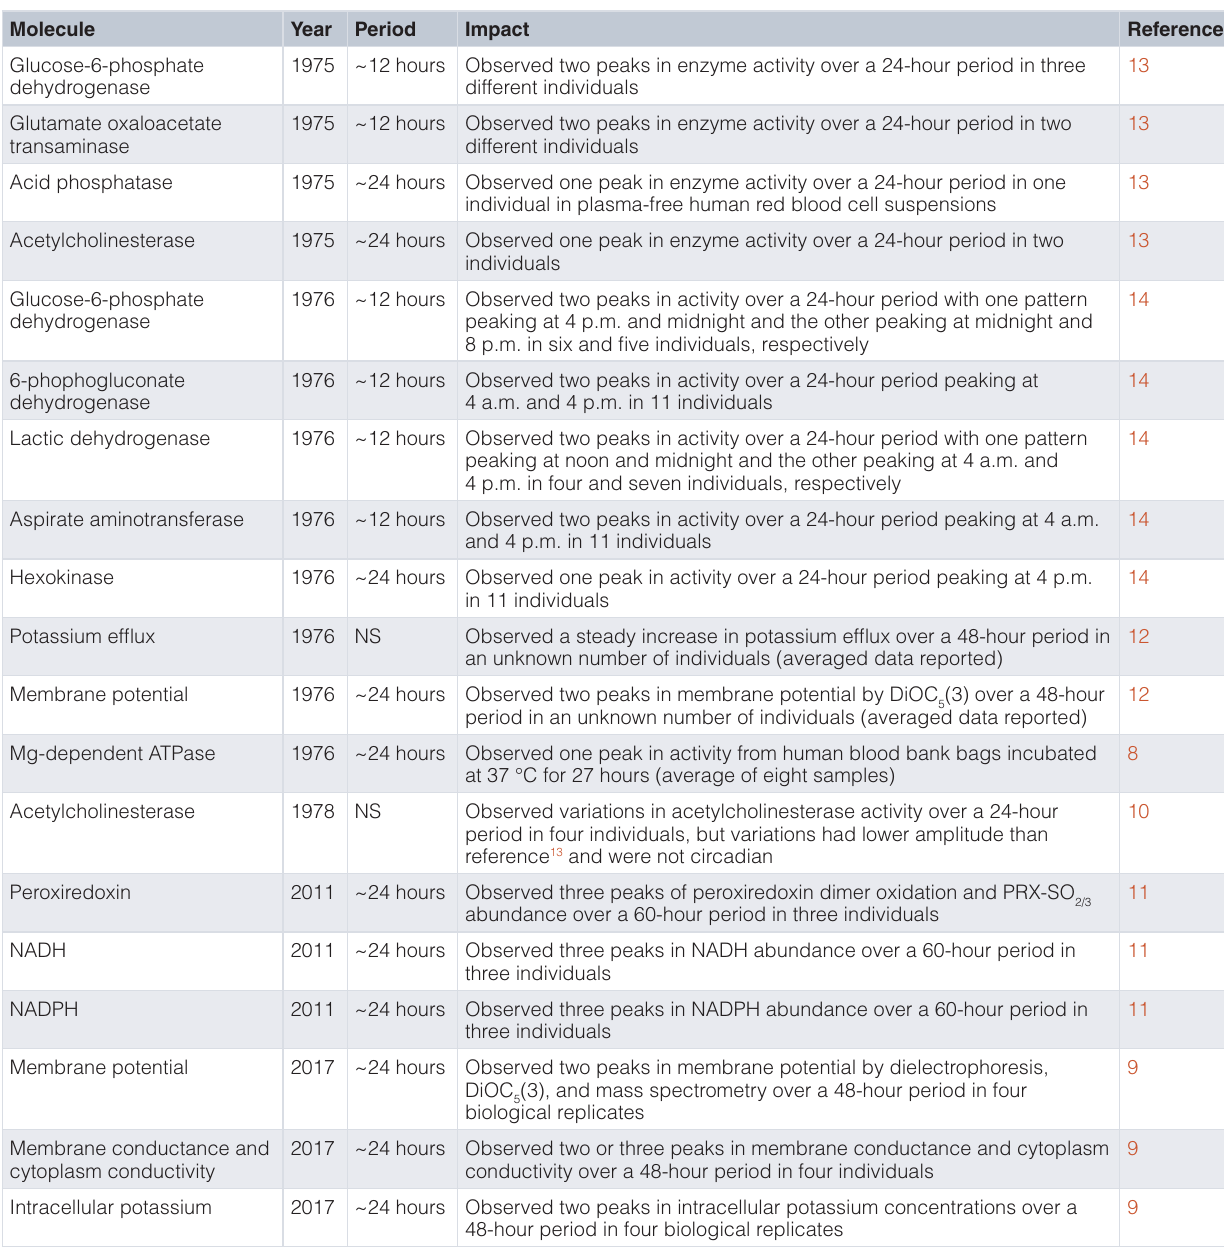
Table 1. Oscillatory phenomena observed in human red blood cells. Molecule Year